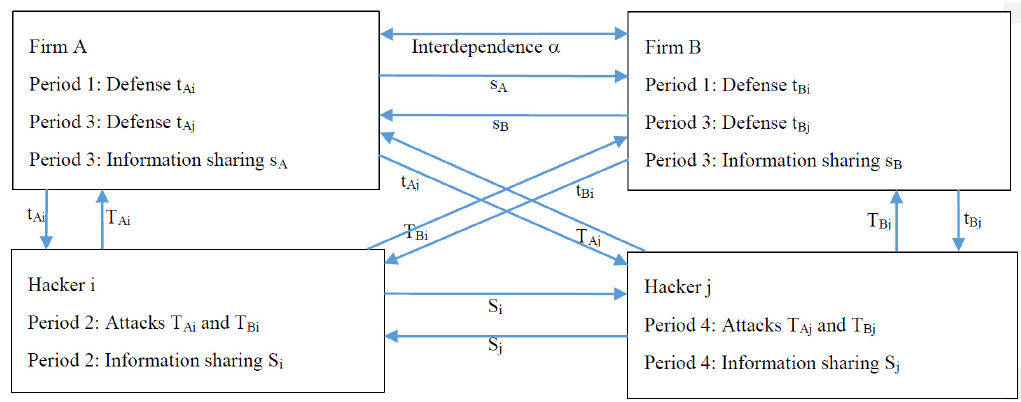
Figure 2. Interaction between two firms and between two hackers.